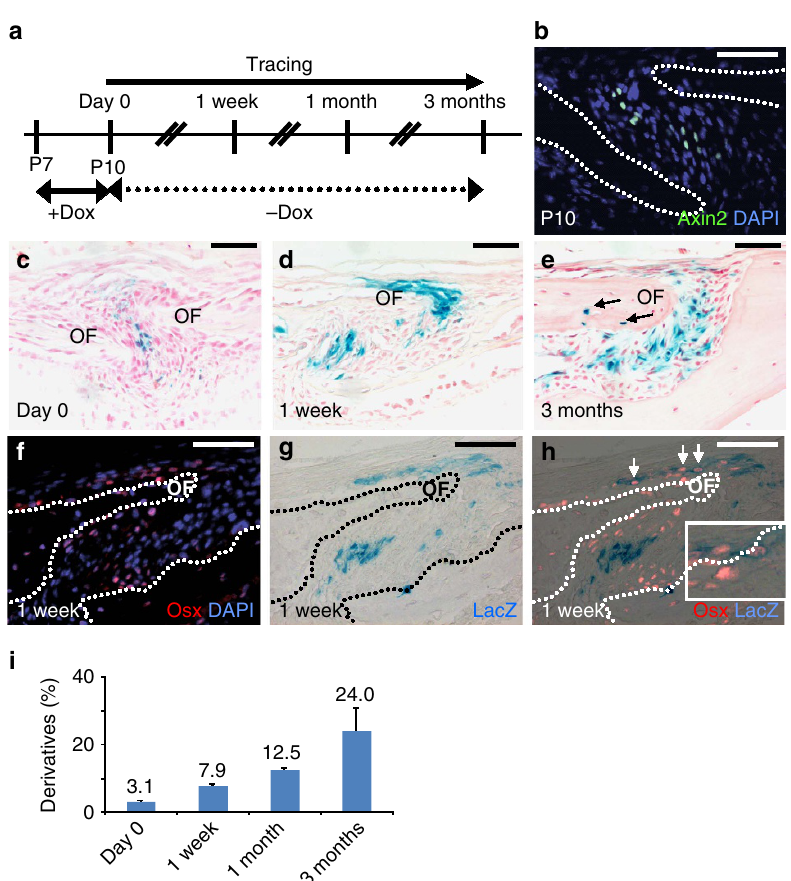
Figure 3 | Cells expressing Axin2 are capable of self-renewal and differentiation into osteogenic cell types during skeletal development. ( a ) A diagram illustrates tracing of the Axin2-expressing cells in developing calvarium. GFP analysis detects the Axin2-expressing cells at P10 before the start of tracing ( b ). The Axin2-expressing cells and their descendants before tracing (Day 0; c ), or after tracing for 1 week ( d ) and 3 months ( e ) are identified by b -gal staining. Double labelling analysis examines the expression of Osx in the Axin2-expressing cells and their descendants after 1 week tracing ( f – h ). Statistical analysis indicates that the ratio of the lacZ-positive cells gradually increases over time ( i , B 300 cells counted, n ¼ 3, mean ± s.e.m.). Genotypes: Axin2-rtTA; TRE-H2BGFP ( b ) and Axin2rtTA; TRE-Cre; R26R ( c – h ). Images are representatives of three independent experiments. Scale bar, 50 m m ( b – h ). OF, osteogenic